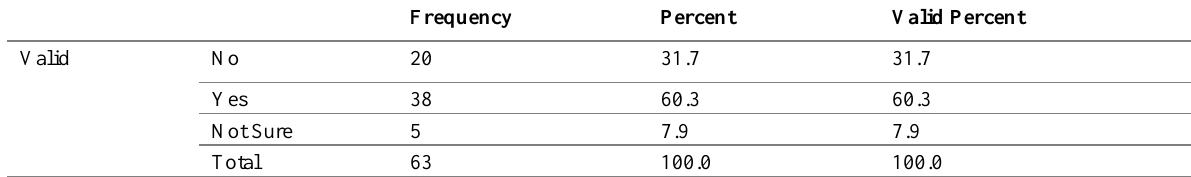
Table 9: ICT Infrastructure